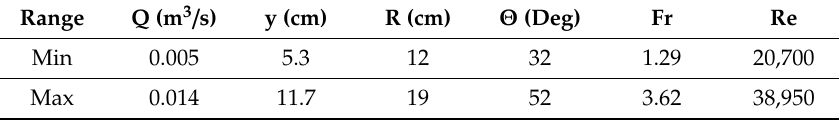
Figure 2. Illustration of ogee spillway in flume, bucket, and block. Table 1. Dimensions, and hydraulic experimental and numerical parameters.